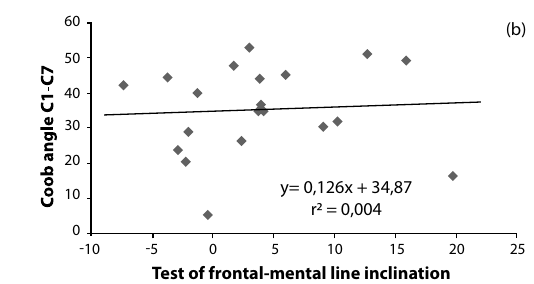
Figure 2 – Correlation between the frontal-mental line inclination and Cobb angle C1-C7: (a) group with anterior head position, (b) group with non-anterior head